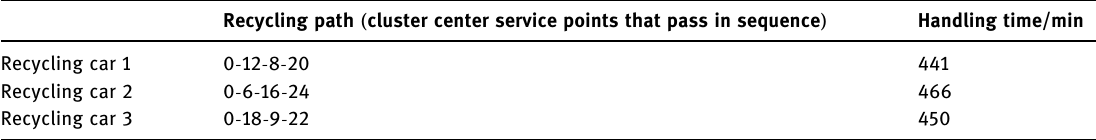
Table 2: Travel path and handling time Recycling path ( cluster center service points that pass in sequence )